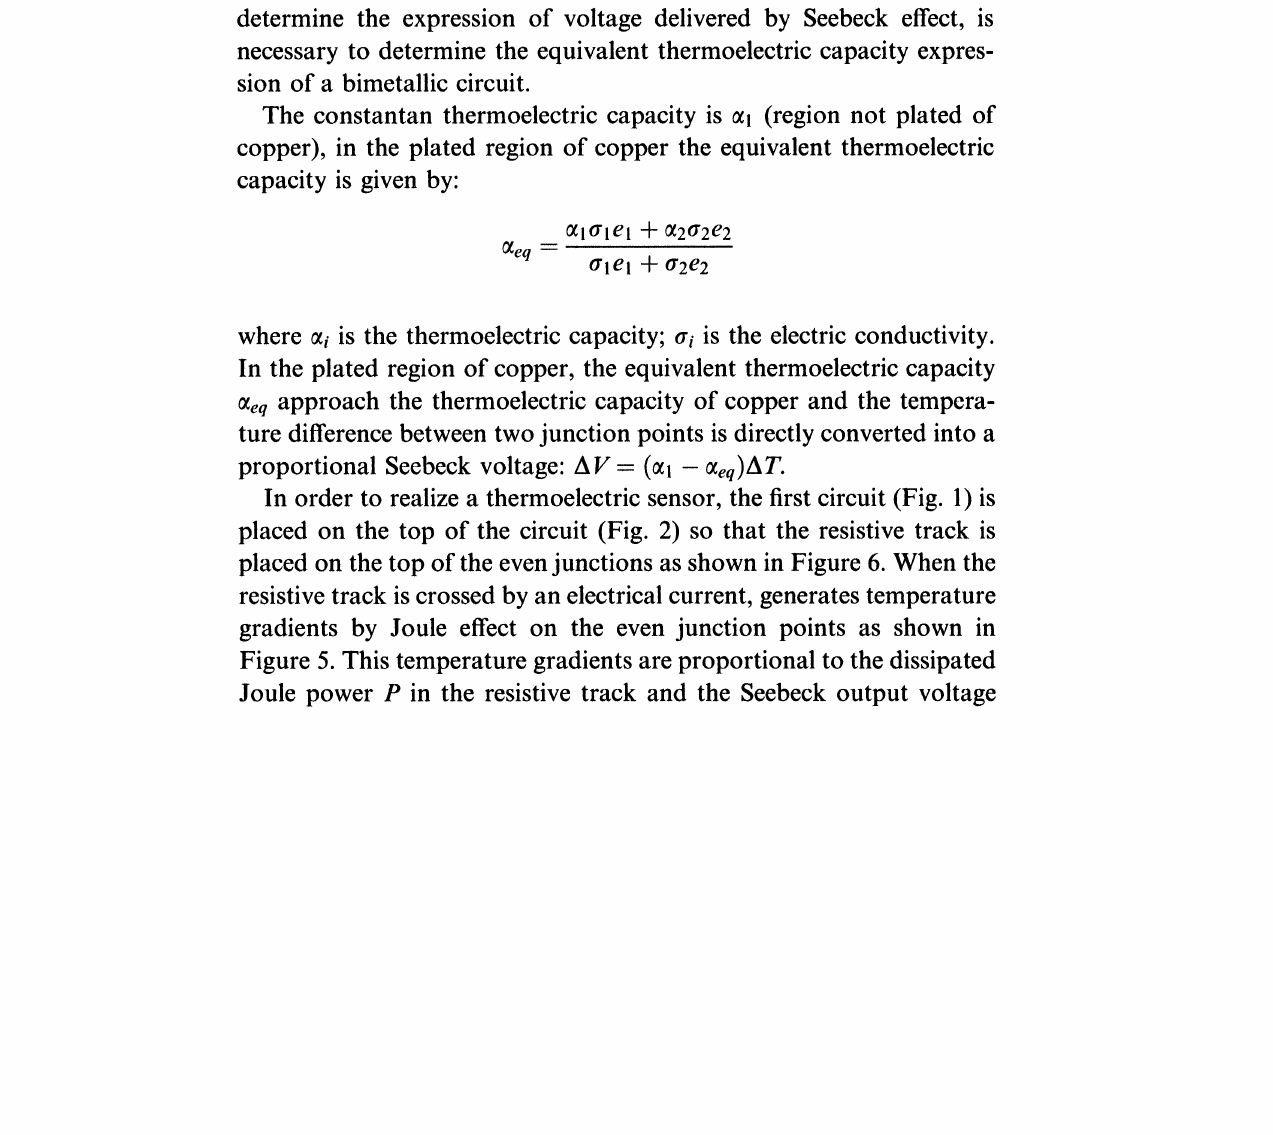
FIGURE 4 Thermoelectric